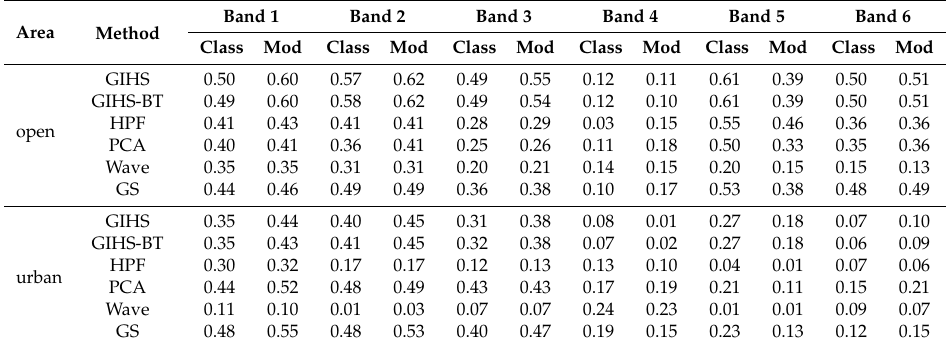
Table 2. Correlation coefficient for the fusion of Landsat 5 TM and WorldView-2 imagery data using the classical (class) and modified (mod) approach.